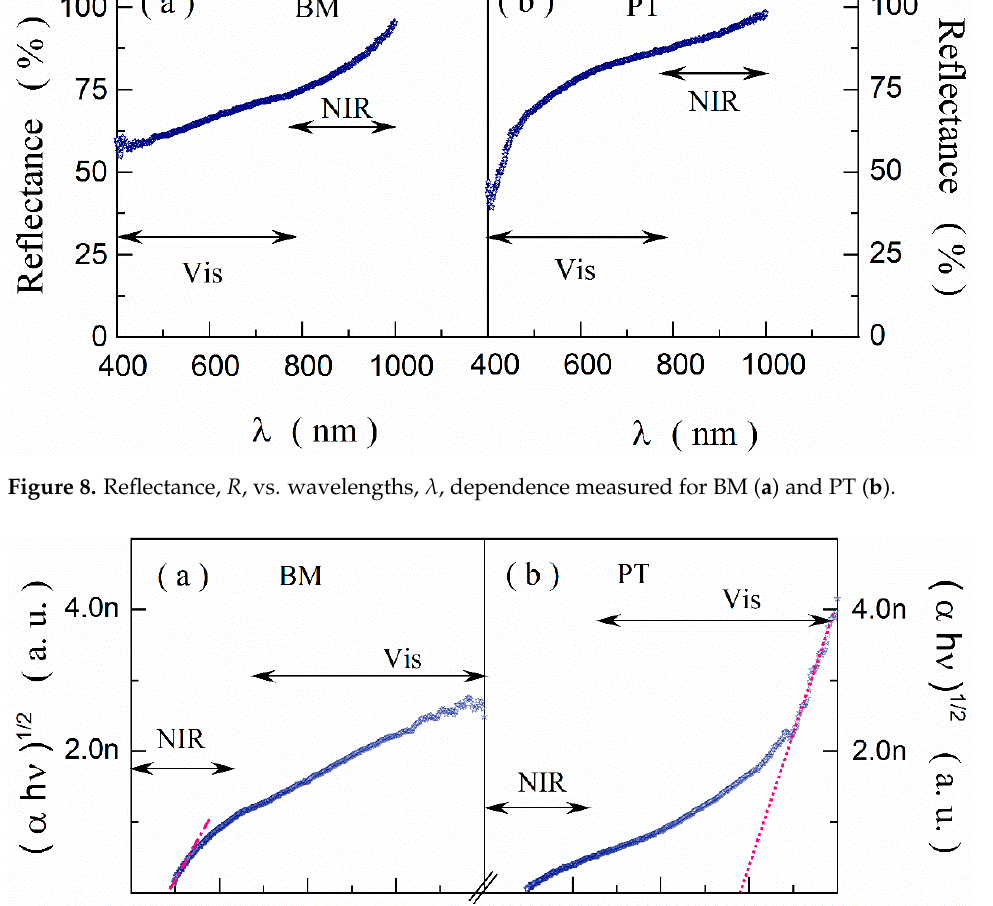
Figure 9. Modified Kubelka-Munk function ( α h ν ) 1/2 vs. photon energy h ν plot obtained for BM ( a )